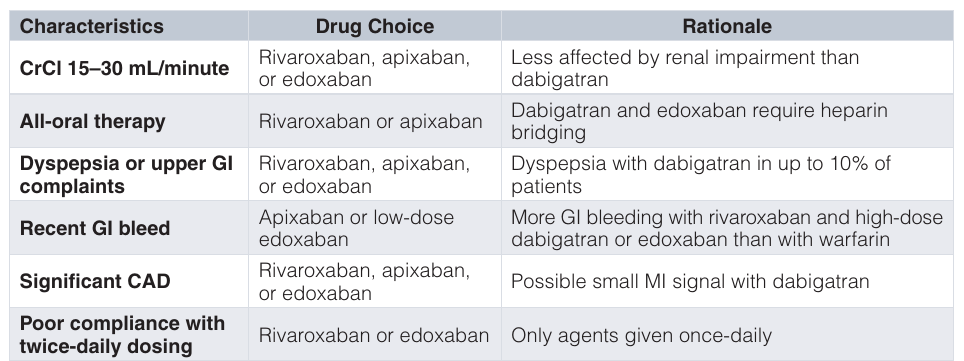
Table 2. Choosing amongst the direct oral anticoagulants.